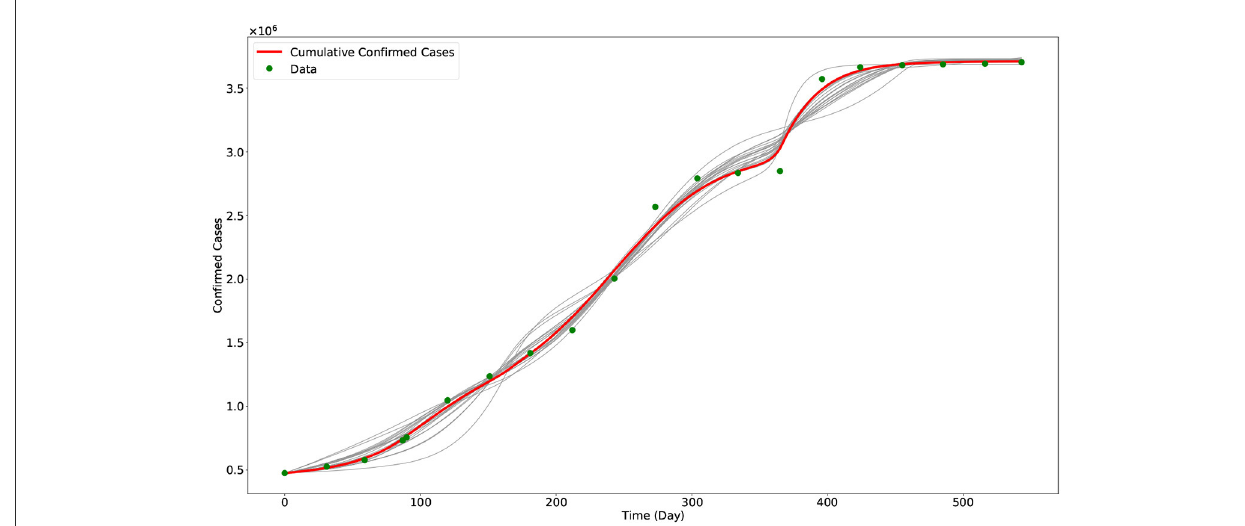
FIGURE2 Output of the model with calibrated parameters compared with data. The gray curves represent the other outputs of the approximate Bayesian computation approach, while the red curve represents the best fit model output (i.e., using the parameters in Table 2). The green dots are the data from the COVID-19 data repository of JHU CSSE.